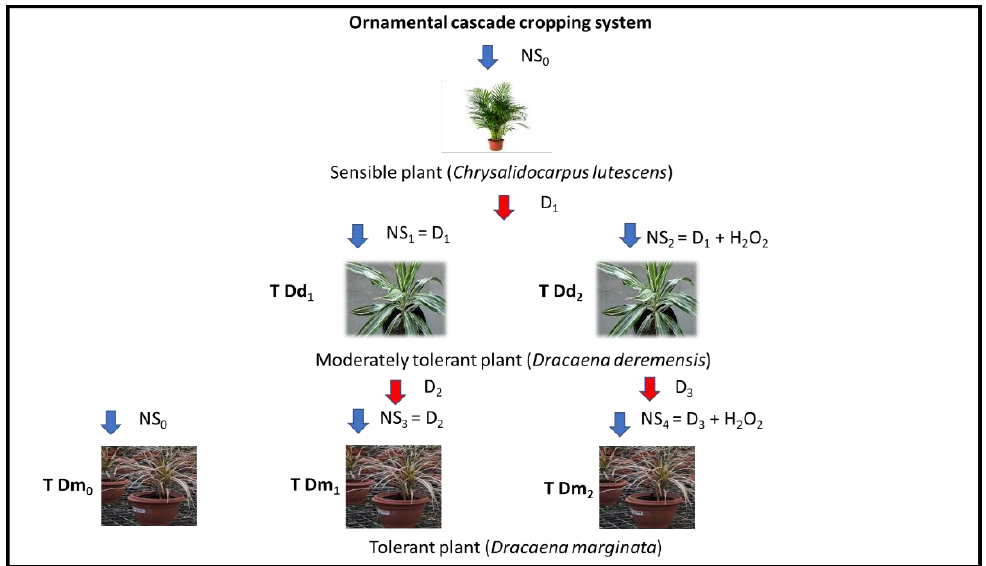
Figure 1. Details of the ornamental cascade cropping system, where NS is the nutrient solution and D is the drainage in each treatment, respectively.